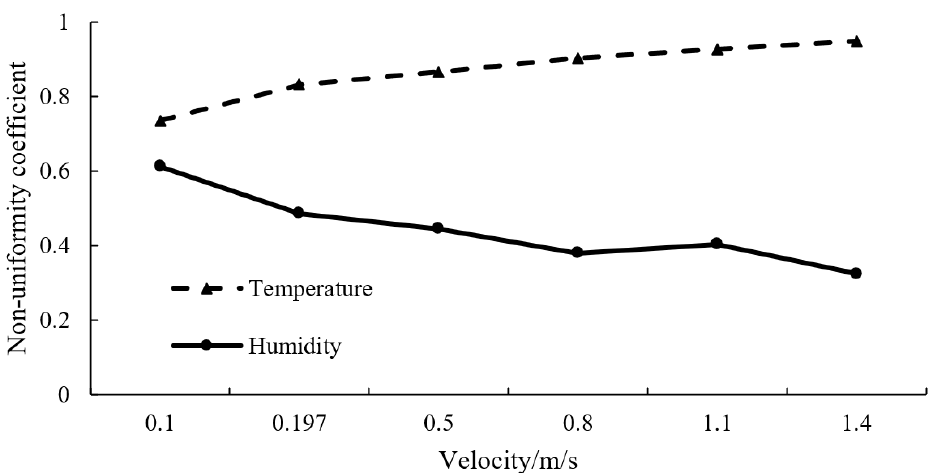
Figure 11. Difference in body surface comfort of pigs under different velocities.